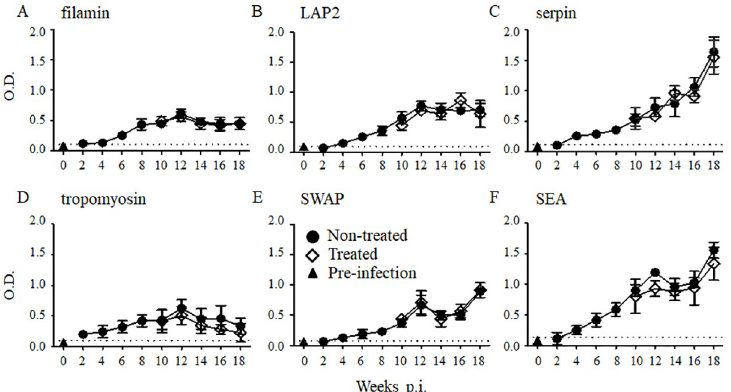
Fig 2. IgG responses to the S . mansoni antigens during S . mansoni infection and after the treatment. Five mice were infected with 50 S . mansoni cercariae, and the sera were collected from five mice at each time point. A group of mice was orally treated twice with 500 mg/kg PZQ at 8 weeks post-infection. The experiment was repeated for 3 times and the representative data are presented. The means of the IgG level to the S . mansoni recombinant filamin (A), LAP2 (B), serpin (C), tropomyosin (D), and crude SWAP (E) and SEA (F) are shown with the standard errors. The dashed line represents the cut-off value (mean + 3SD of the OD of the pre-infected group). Total IgG levels of the treated group (open diamonds) were compared with those of the untreated group (closed circles) and with those of pre- infection samples taken at week 0 (closed